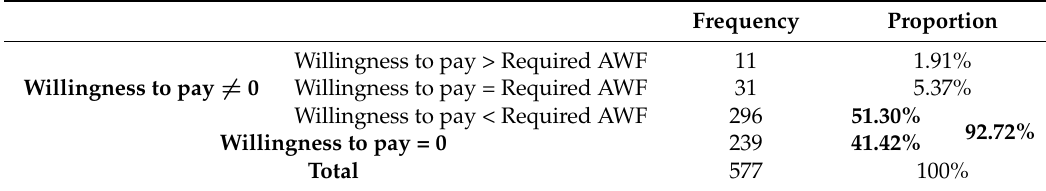
Table 2. Comparison of farmers’ willingness to pay and the required